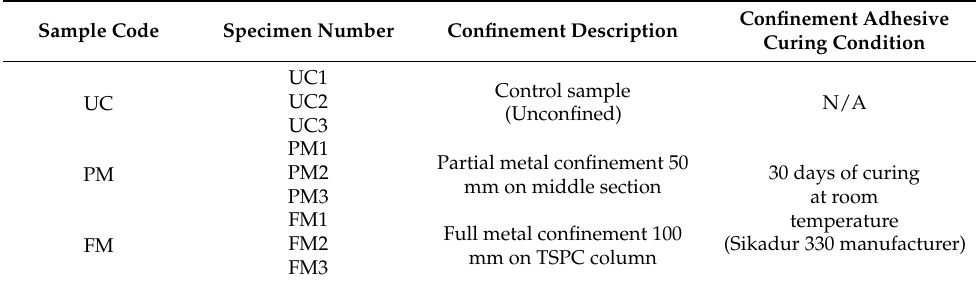
Table 2. Description of test samples and specimen code.